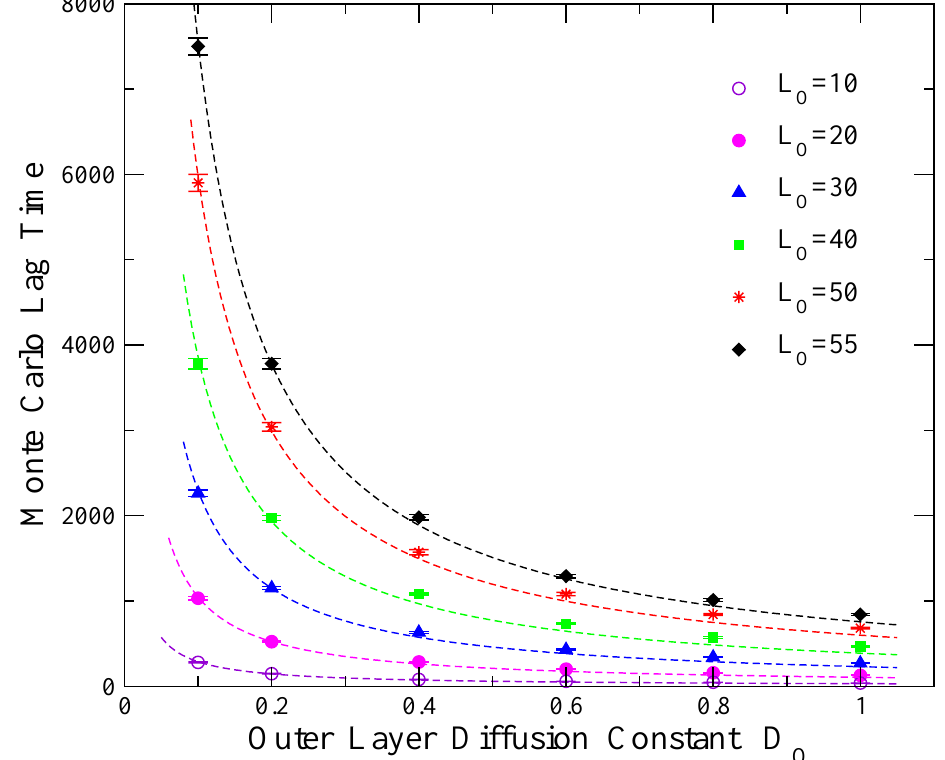
Figure 5. Dependence of lag time on the relative drug diffusion coefficient D O of the outer layer. Different symbols show the lag time of the Monte Carlo simulations as a function of D O , for different values of outer layer thickness L O according to the labelling indicated in the plot. The other param- eters are L = 60, L x = L y = 20 and C 0 = 0.5. Error bars represent mean-value errors calculated through 100 Monte Carlo realizations. Dashed lines are fittings with an inversely proportional function, t lag = b/D O .